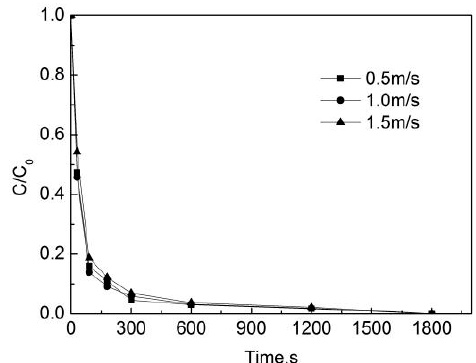
Figure 8. Degradation of OFL under different flow rates in the water distribution system.